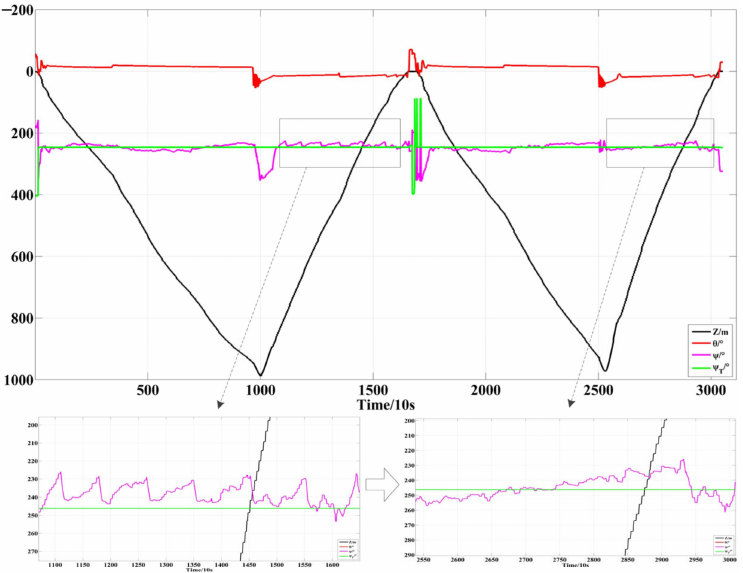
Figure 18. Parameter variation caused by compensation of rotation angle